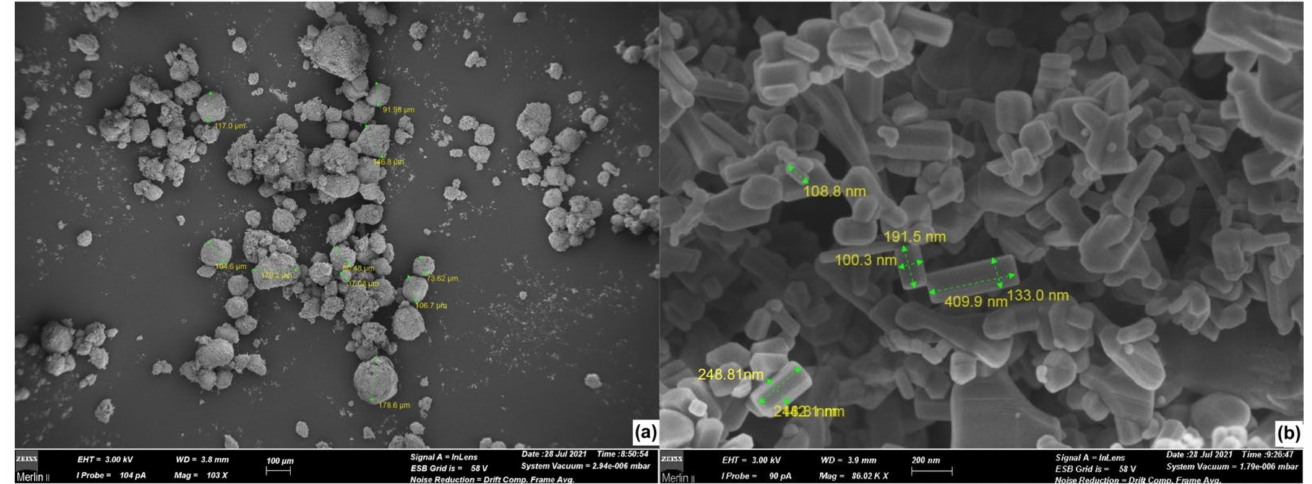
Figure 1. ( a ) Micrometric clusters of ZnO nanoparticles present in untreated dust and ( b ) ZnO nanoparticle size after sonication treatment (FESEM